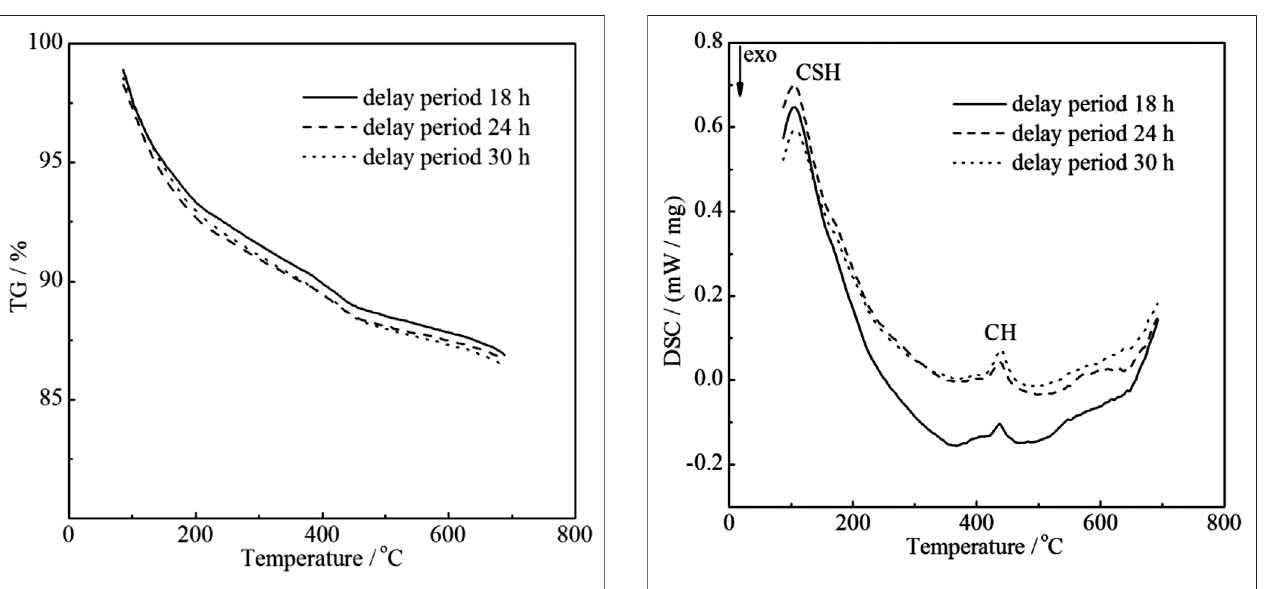
Figure 12 | TG curves of the paste under different delay period.